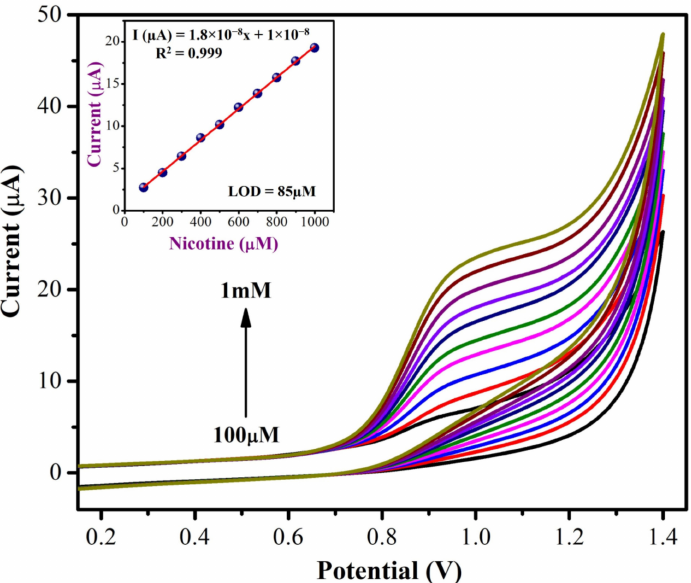
Figure 9. CVs were recorded with different concentrations of NIC (from 100 µ M to 1 mM) using MXene/PHC/GCE in 0.1 M phosphate buffer (pH 7.4) at a scan rate of 50 mV s − 1 . Inset: Calibration curve of NIC, which was plotted between different NIC concentrations ( µ M) and I pa of NIC ( µ A).